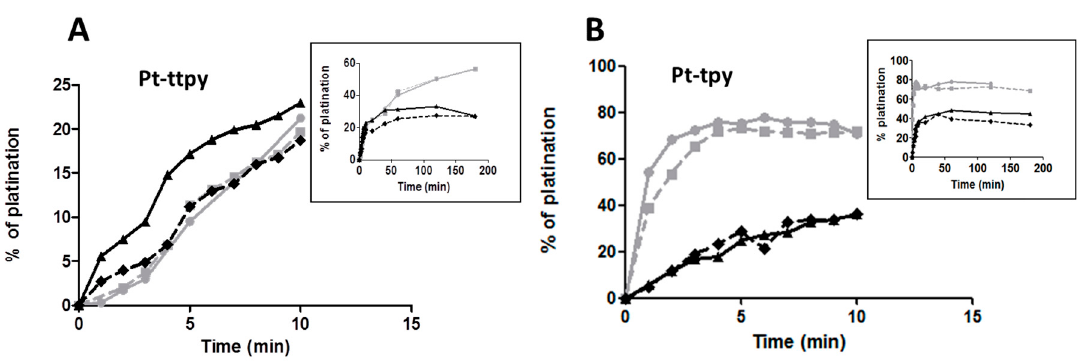
Figure 6. The kinetics of the formation of the platination products on 32 P radiolabelled c-myc* (0.2 µ M) with (grey square) or without (grey circle) cold duplex competitor DNA ds26 (10 µ M) or on 32 P radiolabelled ds26* (10 µ M) with (black triangle) or without (black diamond) cold c-myc competitor (0.2 µ M) in the presence of ( A ) Pt-ttpy or ( B ) Pt-tpy in a K + 10 buffer quantified from the denaturing acrylamide gel electrophoresis (Figures S8 and S9).